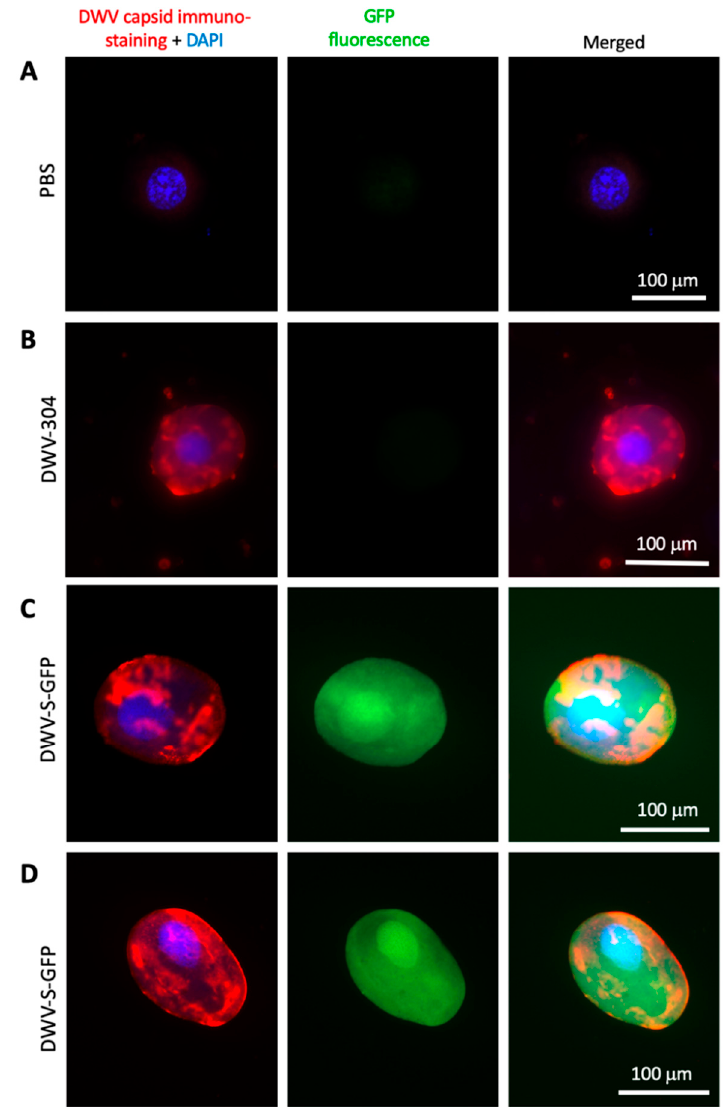
Figure 6. Localization of GFP and DWV structural proteins in the honey bee cells infected with GFP-tagged DWV. Fluorescent microscopy of the cells of the pupae 72 h post injection with PBS control ( A ), the filtered extracts containing 10 7 genome equivalents of DWV-304 ( B ), or DWV-S-GFP ( C , D ). Left panels, immunostaining of the DWV capsids with anti-DWV antisera, Alexa Fluor 647 (red) and DAPI nuclear staining (blue); middle panels, GFP fluorescence (green); right panel, GFP fluorescence combined with Alexa Fluor 647 and DAPI staining.